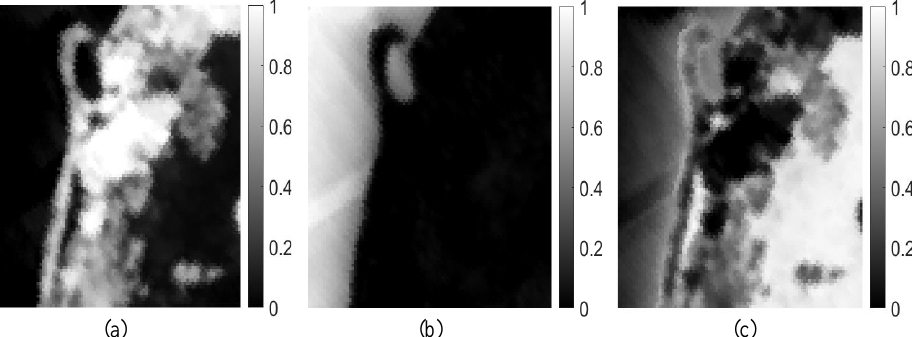
Figure 9. Abundance fraction maps estimated by our MDA-MVSA method from the Samson subim- age: ( a ) tree; ( b ) water and ( c ) soil.